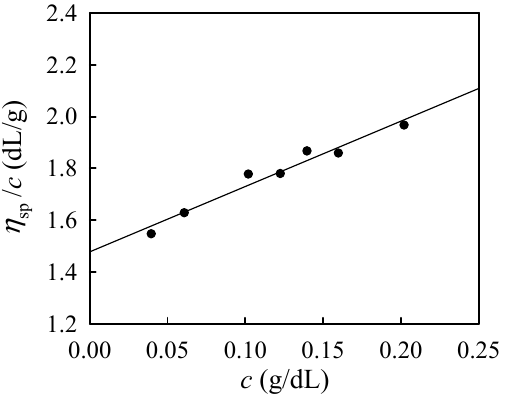
Figure 1. Plots of η sp /c versus c at 20 °C to determine the intrinsic viscosity of a-PNIPAM/H 2 O solution from the intercept at c = 0.